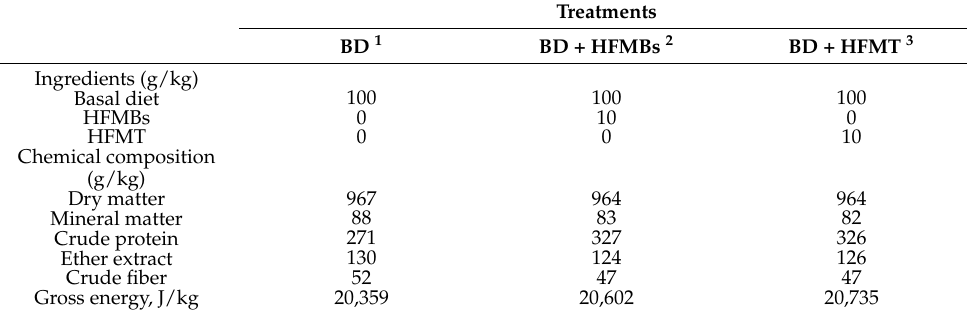
Table 1. Ingredients and chemical composition of experimental diets containing 9.09% feather meal hydrolyzed by Bacillus subtilis (HFMBs) and 9.09% thermal feather meal (HFMT). Treatments BD 1 BD + HFMBs 2 BD + HFMT 3 Ingredients (g/kg) Basal diet 100 100 100 HFMBs 0